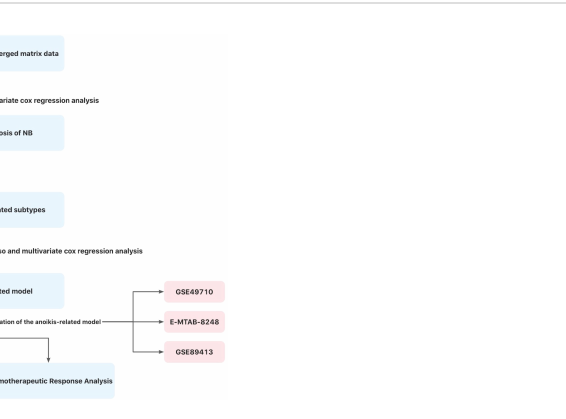
FIGURE 1 Flow chart of this